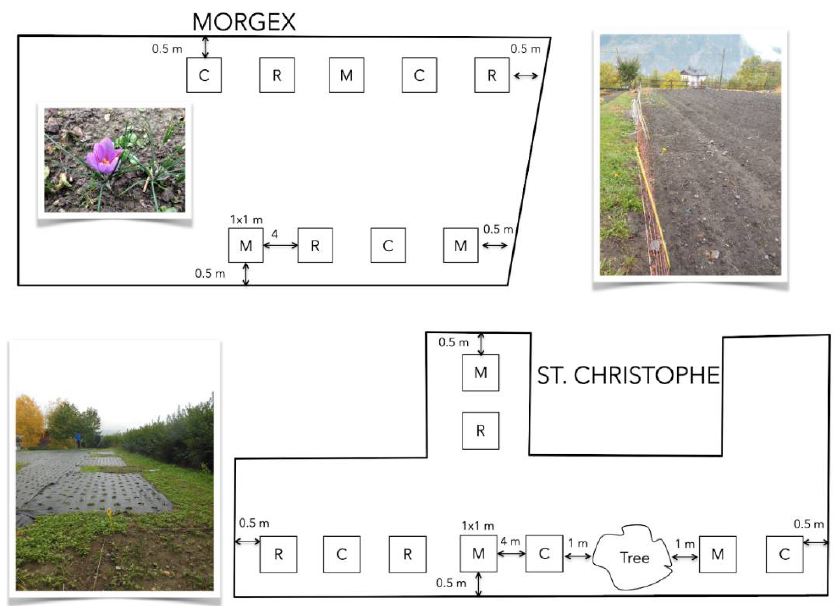
Figure 1. Scheme of the randomized block design in the experimental sites located in the municipality of Morgex (45°45′35.1″ N; 7°02′37.3″ E, 1000 m a.s.l.) and Saint Christophe (45°45′06.9″ N; 7°02′37.0″ E, 700 m a.s.l.), Aosta Valley (AO), Italy. (C = Carrier (Control); R = Single-species inoculum ( Rhizophagus intraradices ); M = Multi-species inoculum (R. intraradices and Funneliformis mosseae ) .